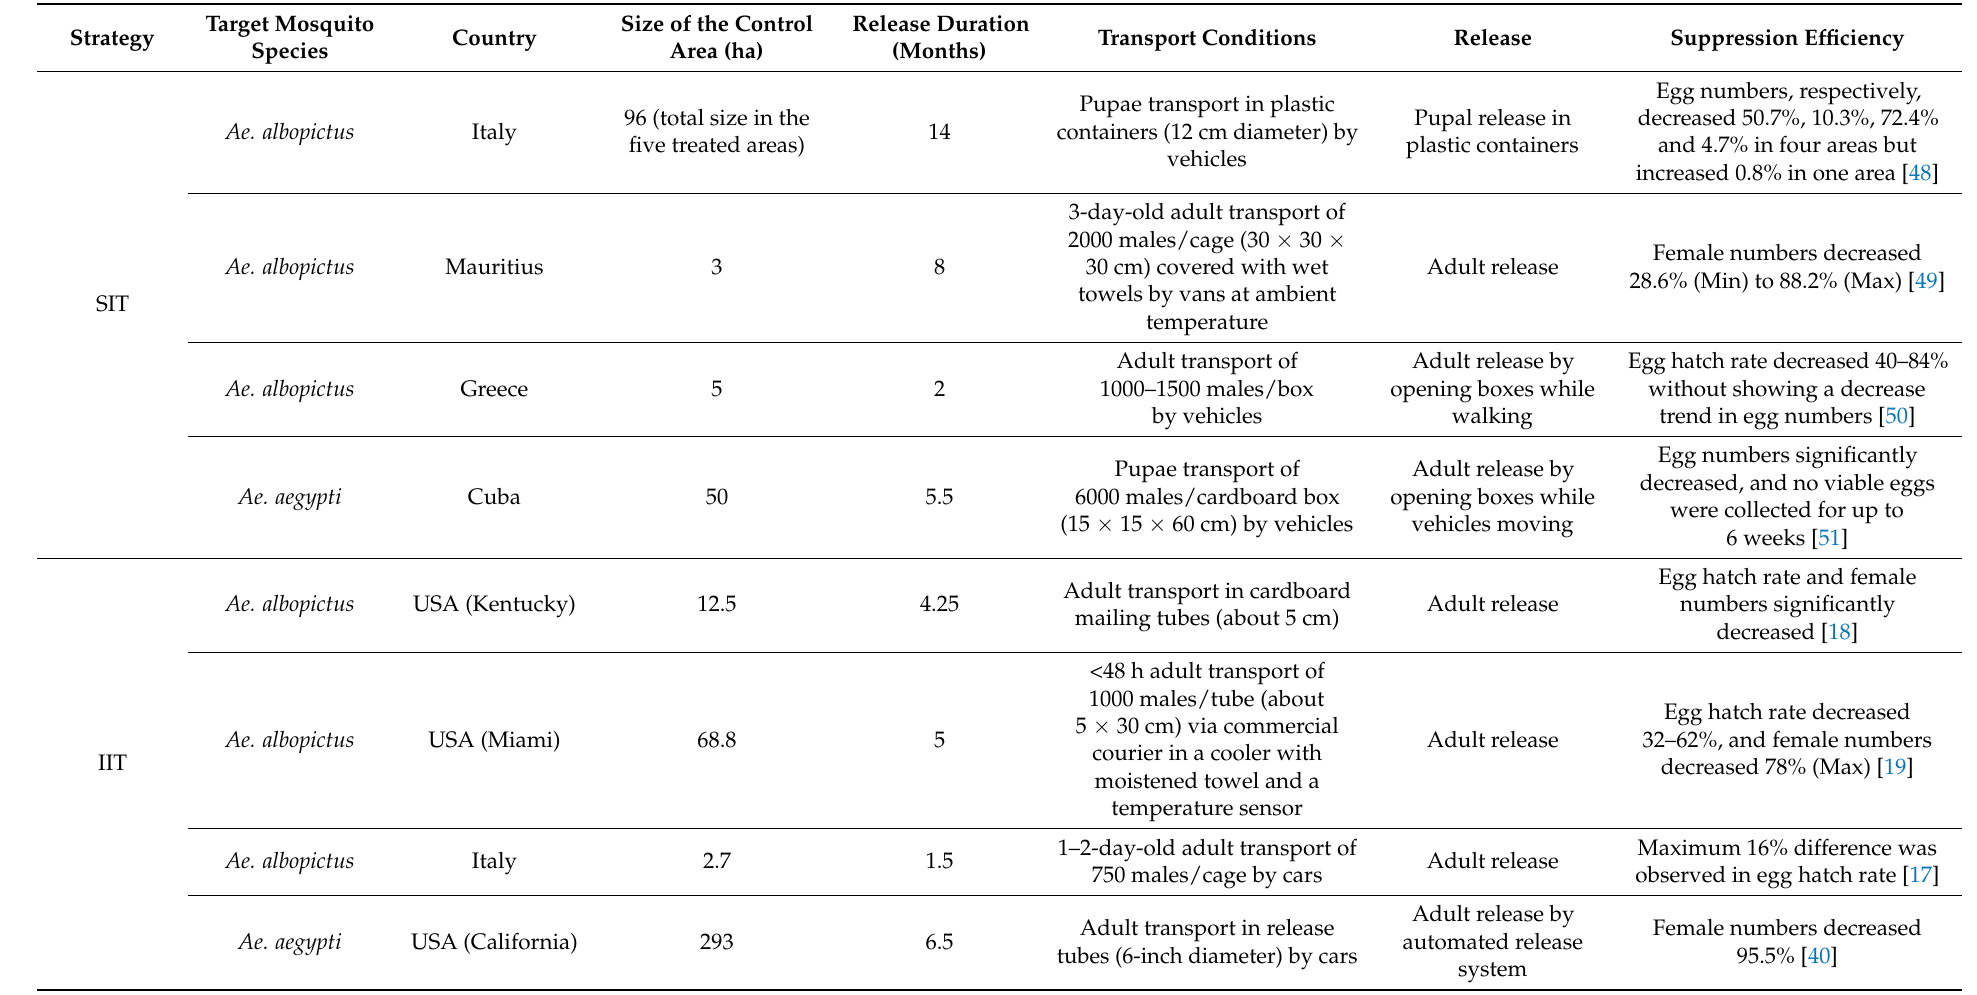
Table 1. Reported open-field trials of Aedes mosquito population control using SIT-related